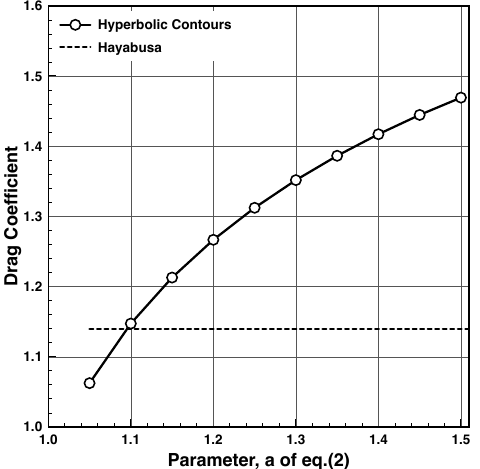
Figure 2. Relationship between the parameter, a , and the drag